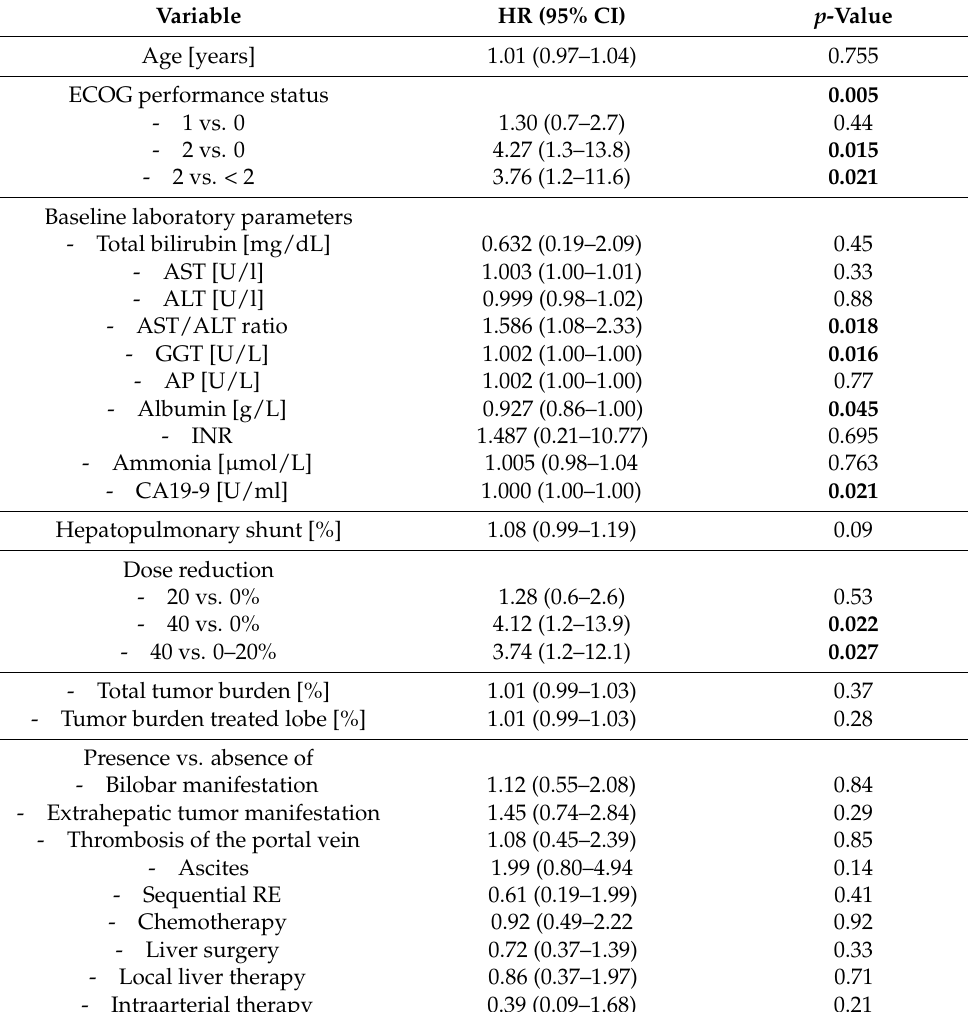
Table 2. Univariable Cox regression. Significant results are printed in